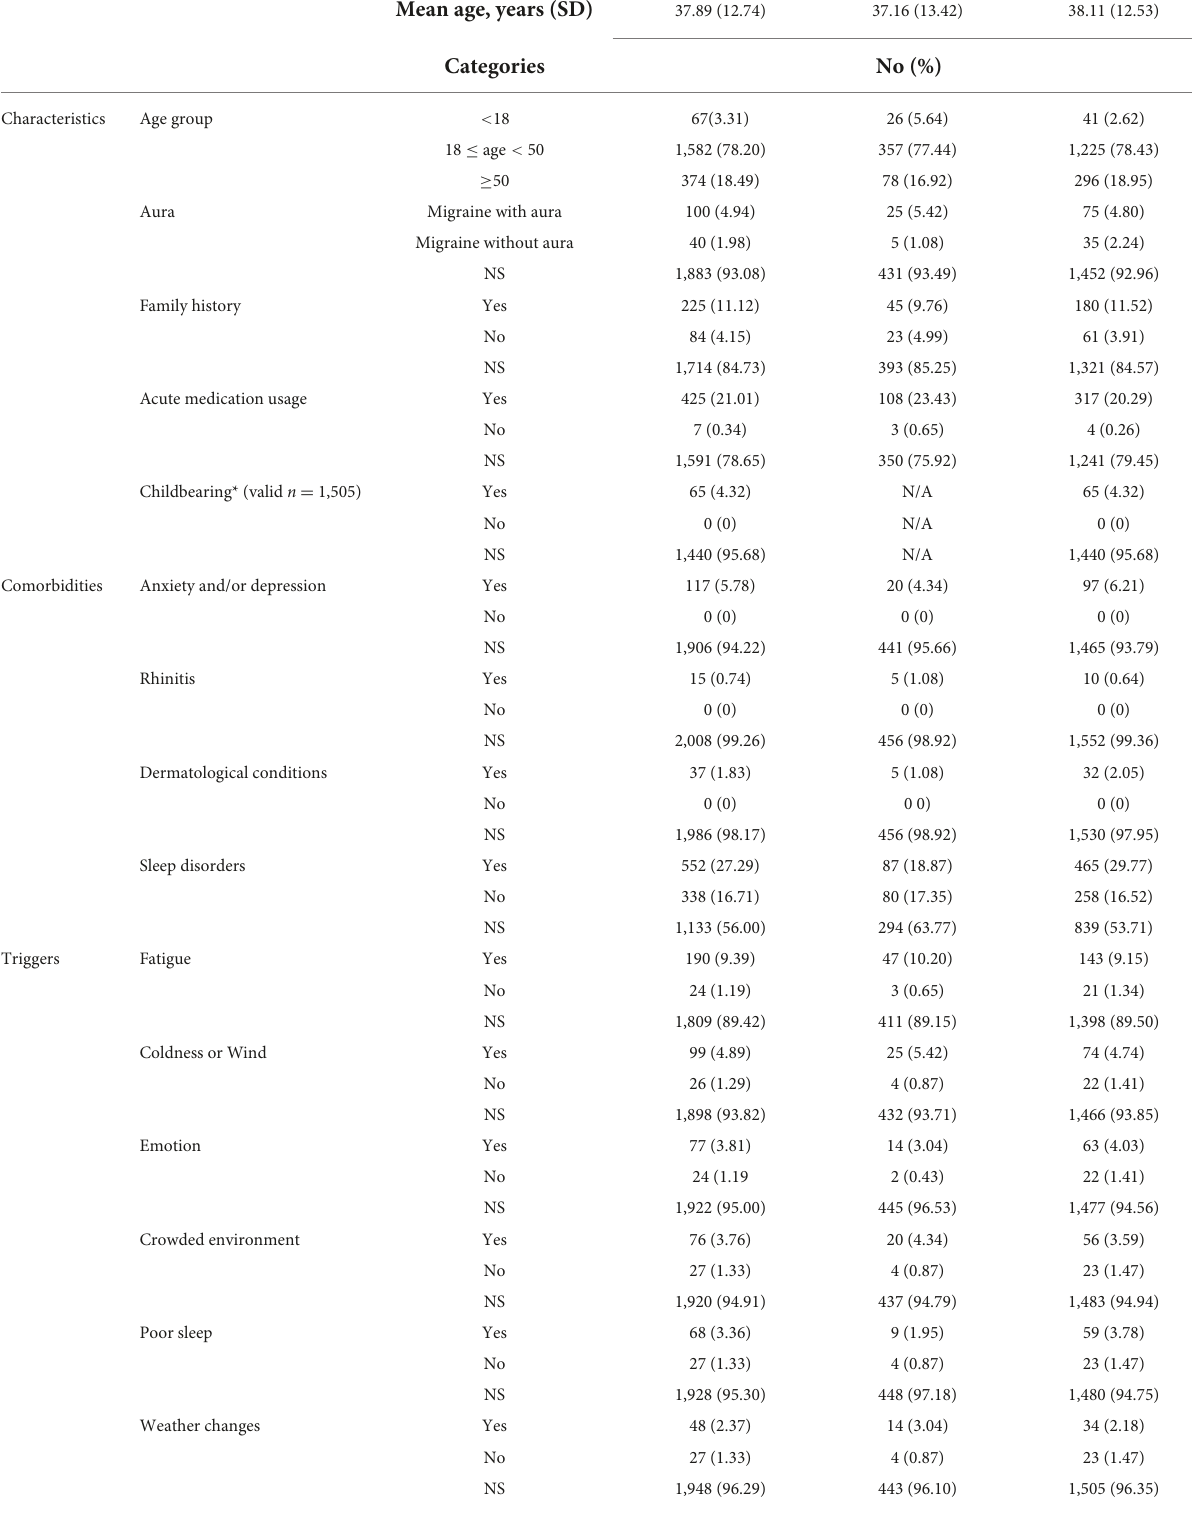
TABLE 1 Characteristics, comorbidities and triggers of the